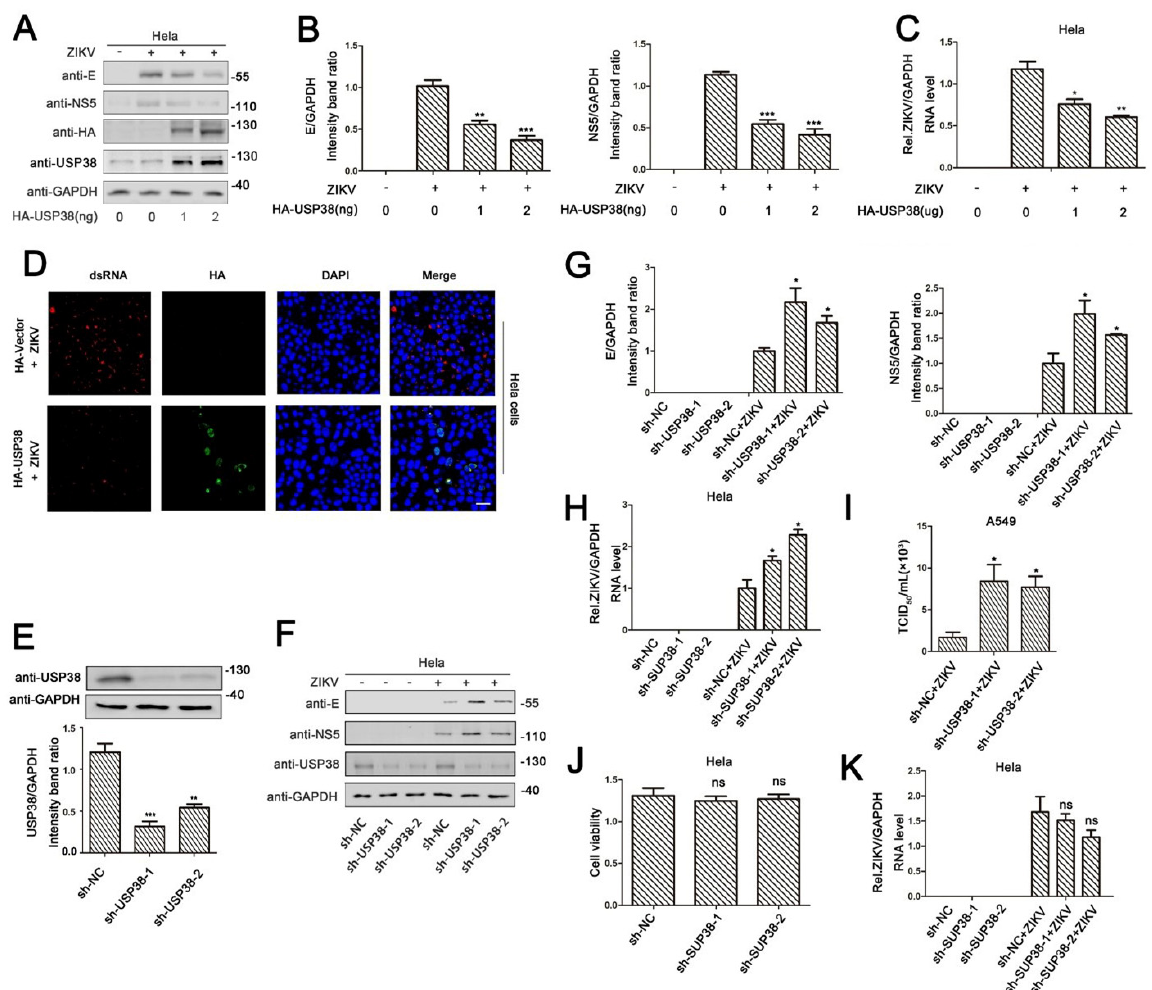
Figure 1. USP38 inhibits ZIKV infection. ( A – D ) Hela cells were transfected with HA-USP38 for 24 h then infected with ZIKV (MOI = 1) for 48 h. The levels of ZIKV proteins were detected by immunoblotting ( A ). E/GAPDH and NS5/GAPDH ratio was measured ( B ). The viral RNA content was quantified by qPCR ( C ) and confocal microscopy ( D ), bar = 10 µ m. ( E ) Hela cells stably expressing sh-USP38 or control sh-RNA, and the USP38/GAPDH ratio was measured. ( F – H ) Hela cells stably expressing sh-USP38 or control sh-RNA were infected with ZIKV (MOI = 1) for 48 h. The expression level of ZIKV proteins were detected by immunoblotting ( F ). The ratios of E/GAPDH (G, left) and NS5/GAPDH (G, right) were measured. The viral RNA content was quantified by qPCR (H). ( I ) A549 cells stably expressing sh-USP38 or control sh-RNA, and the viral titers was measured by TCID 50 . ( J ) Cells were measured for cell viability by CCK-8 assay, and the unit of the y axis is the readout optical density (OD) value. ( K ) Hela cells stably expressing sh-USP38 or control sh-RNA were incubated with ZIKV for 2 h, then continue to be cultured with serum-free medium for 48 h. The viral RNA content was quantified by qPCR. *: p < 0.05, **: p < 0.01, and ***: p < 0.001 .